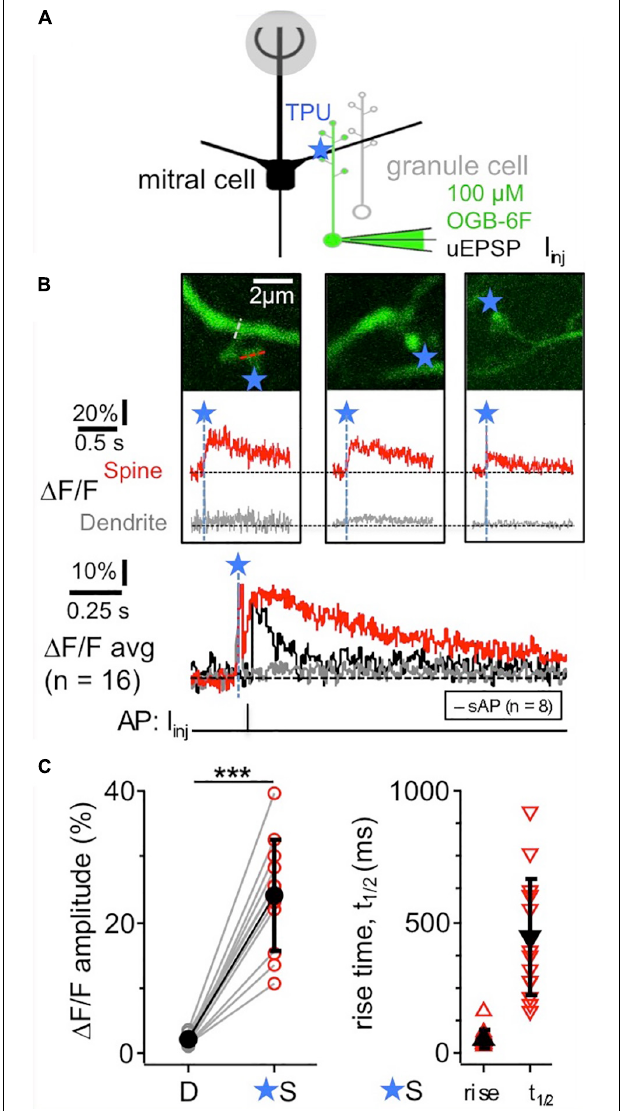
FIGURE 1 | TPU-evoked Ca 2 + entry into juvenile rat GC spines with low exogenous buffering. Imaging of TPU-evoked Ca 2 + transients within GC spines with low exogenous buffering (100 µ M OGB-6F). (A) Scheme of experiment: whole cell recording from GC (filled with dye via pipette) and TPU at spine head. The pipette was also used for brief current injections to evoke somatic APs (sAP). (B) Top: two-photon scans (z-projections) of three representative examples of individual spines filled with OBG-6F. Blue stars denote uncaging locations. Red and gray dotted line indicate line scan positions. Middle: respective averaged fluorescence transients ( (cid:49) F/F) TPU that were collected from line scans across the spine heads above (S, red) and the adjacent dendrite at the base of the spine neck (D, gray). Blue dashed lines and star: time point of uncaging. Bottom: ( (cid:49) F/F) TPU transients averaged across experiments (Ca 2 + imaging: n = 11 spines) with the same time axis, spine response in red and dendrite response in gray. The black trace in the Ca 2 + imaging graph represents the averaged response ( (cid:49) F/F) AP to a backpropragating somatically evoked AP (recorded in n = 8 of the 11 spines). (C) Cumulative plots of ( (cid:49) F/F) TPU amplitudes in dendrite and spine pairs (highly significantly different: P < 0.001, Wilcoxon test), and of rise times and half durations t 1 / 2 of ( (cid:49) F/F) TPU within the spine heads (mostly not detectable in the